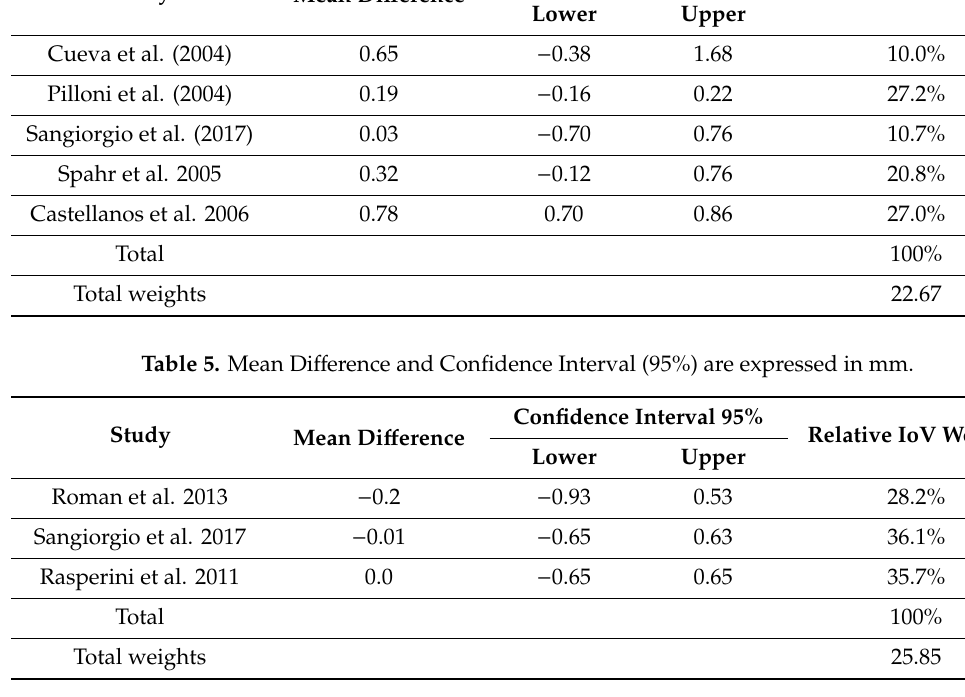
Table 6. Summary of Heterogeneity Measures.